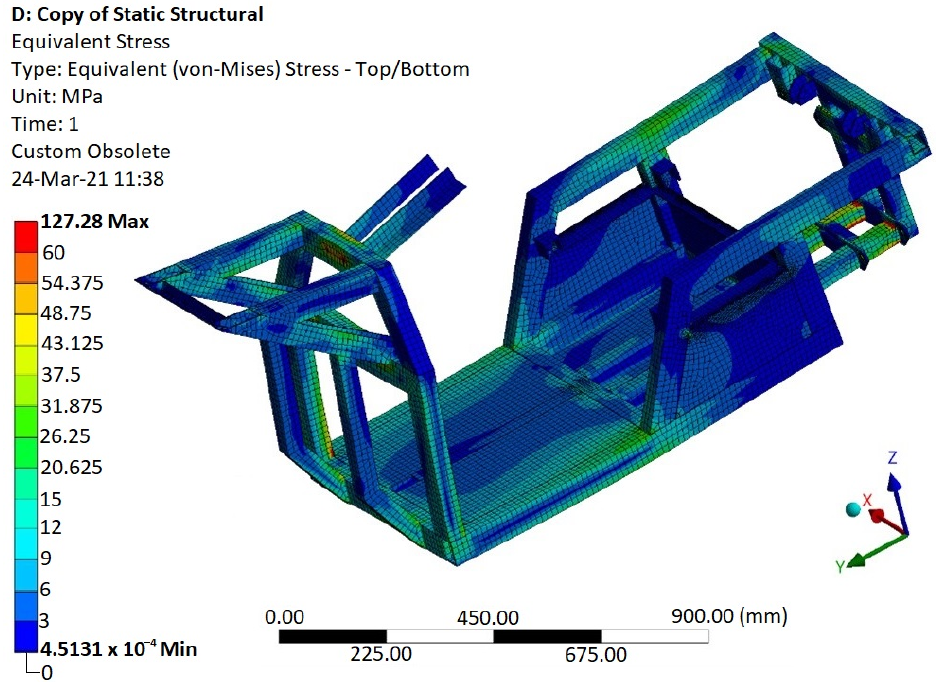
Figure 19. Simulated stresses in the E3-cycle frame in the course of cornering to define the mean stress as an input for fatigue life assessment.